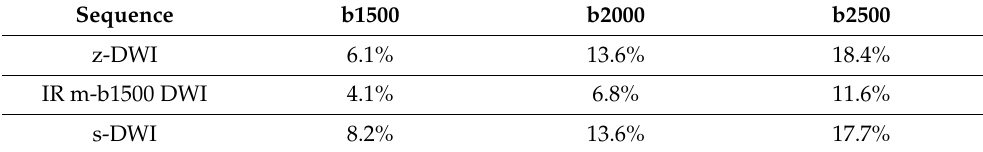
Table 2. Percentage of undetected lesions for each sequence and b-value combination. Sequence